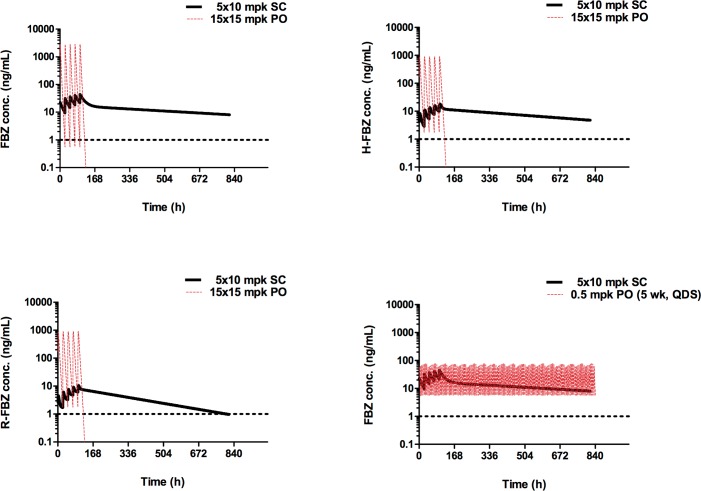
Comparison between oral PK profile (dashed red lines) and s.c. injection PK profile (solid black line) in CB.17 SCID mice as assessed from PK modelling of exposure data. (Top left) FBZ PK after 10mg/kg qd 5x s.c. FBZ or 15mg/kg qd 5x oral FBZ. (Top right) H-FBZ PK after 10mg/kg qd 5x s.c. FBZ or 15mg/kg qd 5x oral FBZ. (bottom left) R-FBZ PK after 10mg/kg qd 5x s.c. or 15mg/kg qd 5x oral FBZ. (bottom right) Simulated FBZ PK profile after 10mg/kg qd 5x s.c. or 5 week, 4 times daily (qds) regimen of 0.5mg/kg oral FBZ.